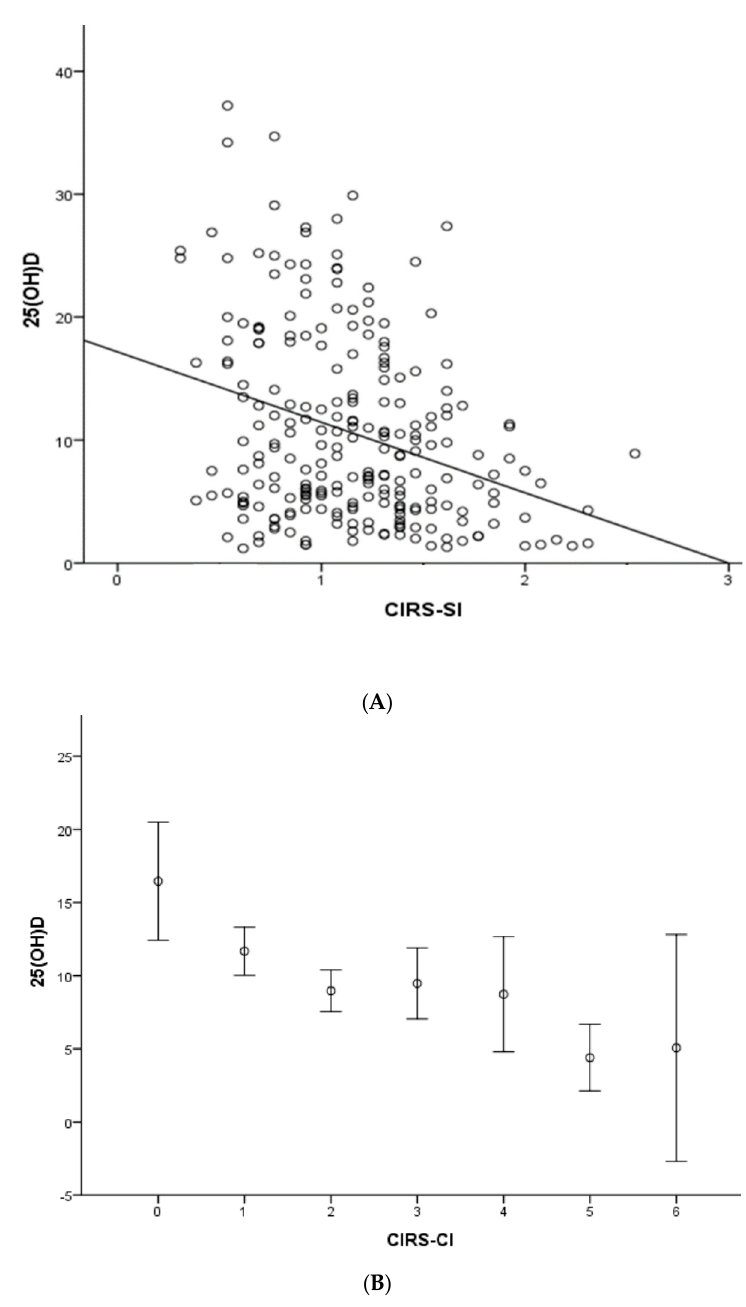
Figure 1. Simple correlation analysis between serum 25 (OH)D concentrations and CIRS-SI ( A ) and CIRS-CI ( B ), in the whole cohort ( n = 237). 25(OH)D: 25-hydroxyvitamin D expressed in ng/mL; CIRS-SI: Cumulative Illness Rating Scale-Severity index; CIRS-CI: Cumulative Illness Rating Scale-Comorbidity index. ( A ) Simple correlation between 25(OH)D concentration and CIRS-SI scores ( r : − 0.312; p < 0.0001); ( B ) simple correlation between 25(OH)D concentration and CIRS-CI ( r : − 0.306; p < 0.0001). r = Pearson’s correlation coefficient; p = statistical significance of Pearson’s correlation coefficient.